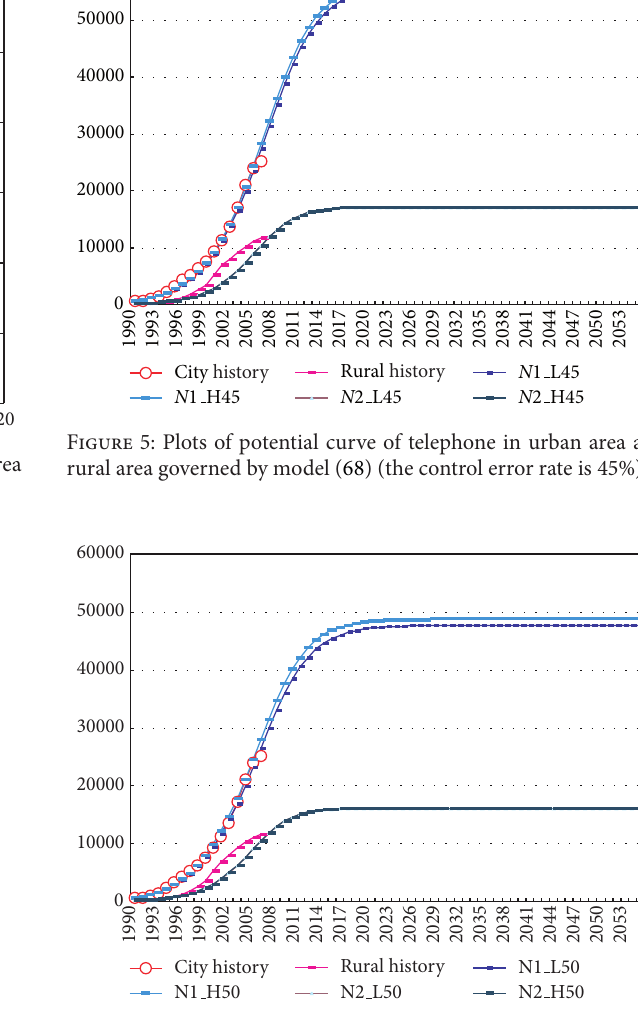
from 54203.57 to 73615.08 in respect to different control